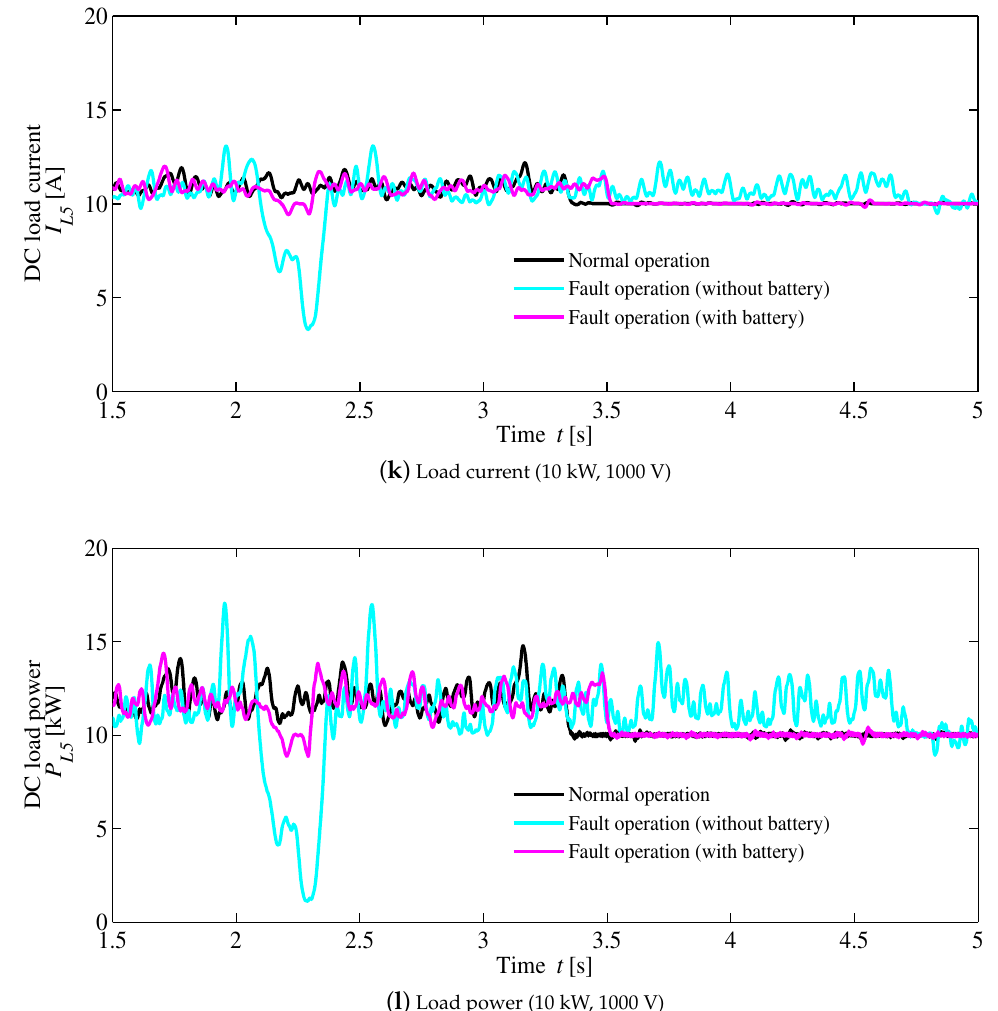
Figure 13. Simulation results of the different